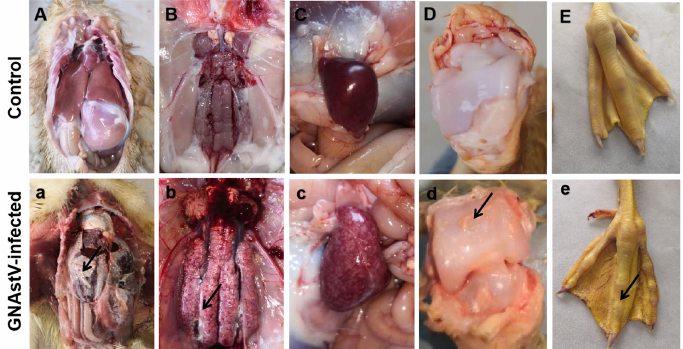
Figure 1. Gross anatomical changes in goslings associated with GNAstV-mediated mortality. No changes were observed in the liver ( A ), heart ( A ), kidney ( B ), spleen ( C ), articular cavity ( D ) and claw ( E ) in the control goslings. Urate deposition on the surface of the liver and heart ( a ), and in the ureter ( b ), articular cavity ( d ) and claw ( e ), swelling and pale coloration of the kidneys ( b ), and enlargement and necrosis of spleens ( c ) were observed in the infected goslings. Black arrow: urate.